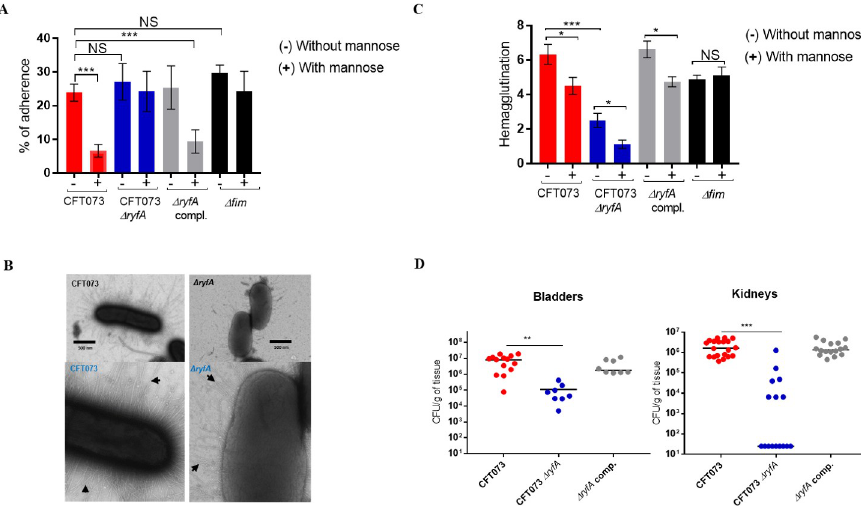
Fig 5. Role of ryfA in the murine model of ascending UTI and in P fimbriae (pili) production. ( A ) Adherence of strain CFT073 and its derivatives to human 5637 bladder epithelial cells in the presence or absence of 2.5% α -d- mannopyranose was determined. ( B ) Electron microscopy of CFT073 and the Δ ryfA mutant. Arrows show fimbriae on cell surfaces. ( C ) Production of Pap fimbriae by hemagglutination assay. Results are the mean values and standard deviations for four biological experiments. ( D ) Single-strain infections to compare wild-type strain CFT073 to Δ ryfA mutant. Results are presented as the log 10 CFU g − 1 . Each data point represents a sample from an individual mouse, and horizontal bars indicate the medians. Two independent series of infections were performed: i (CFT073 WT and CFT073 Δ ryfA ) and ii (CFT073 WT and the complemented mutant). The Δ ryfA mutant was attenuated 146-fold in bladder and 10,000-fold in kidneys compared to the WT parent strain. Data are means ± standard errors of the means of 10 mice. Statistical significance was calculated by one-way ANOVA (A and C) or Mann–Whitney Test (D): � , P < 0.05; �� , P < 0.005; ��� , P < 0.0001. NS, not